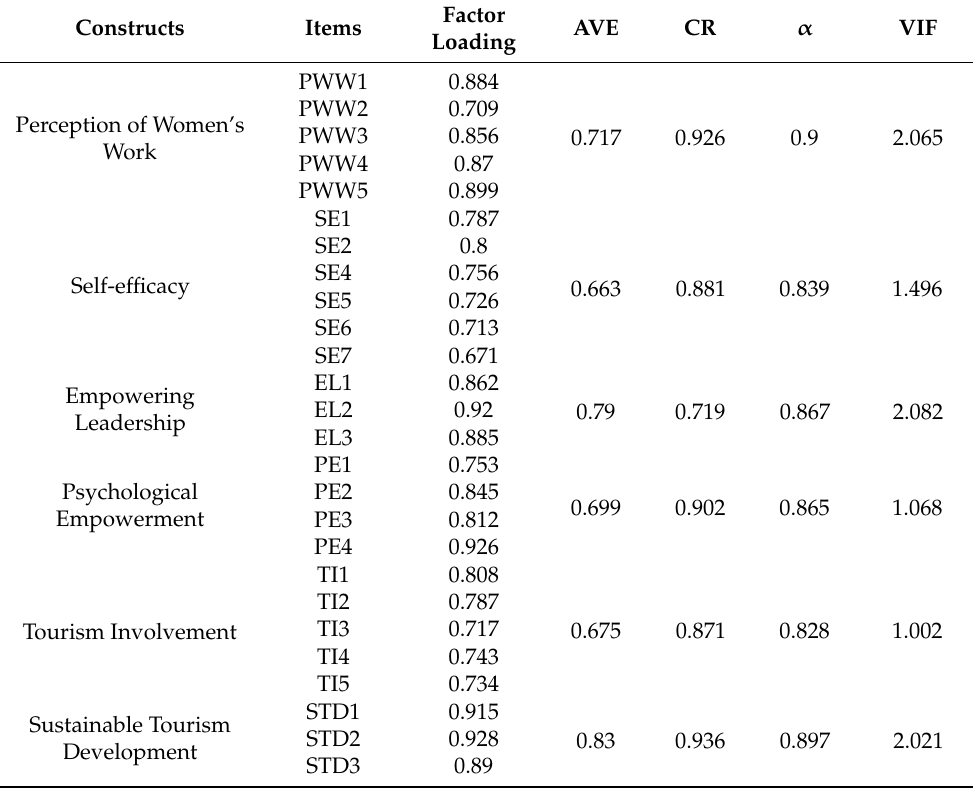
Table 2. Reliability of the constructs and factor loadings of